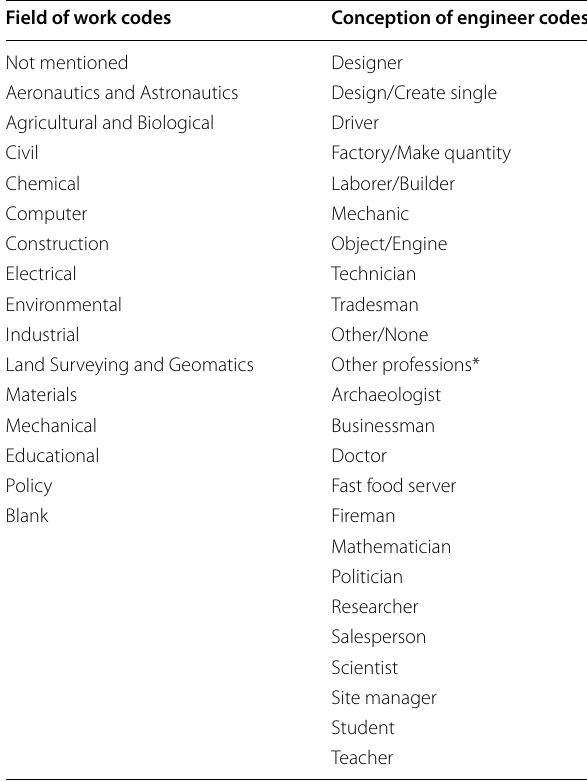
Table 4 Coding scheme used to describe the nature of work of drawn